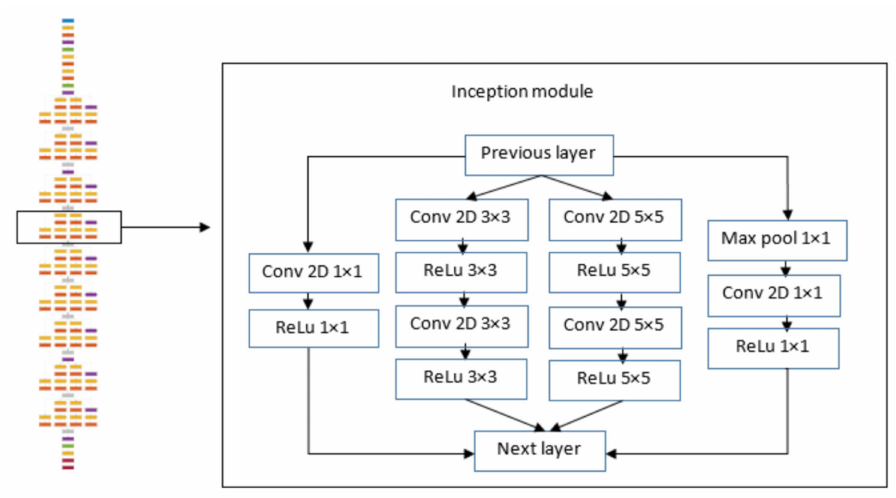
Figure 1. GoogLeNet architecture; the inception module is